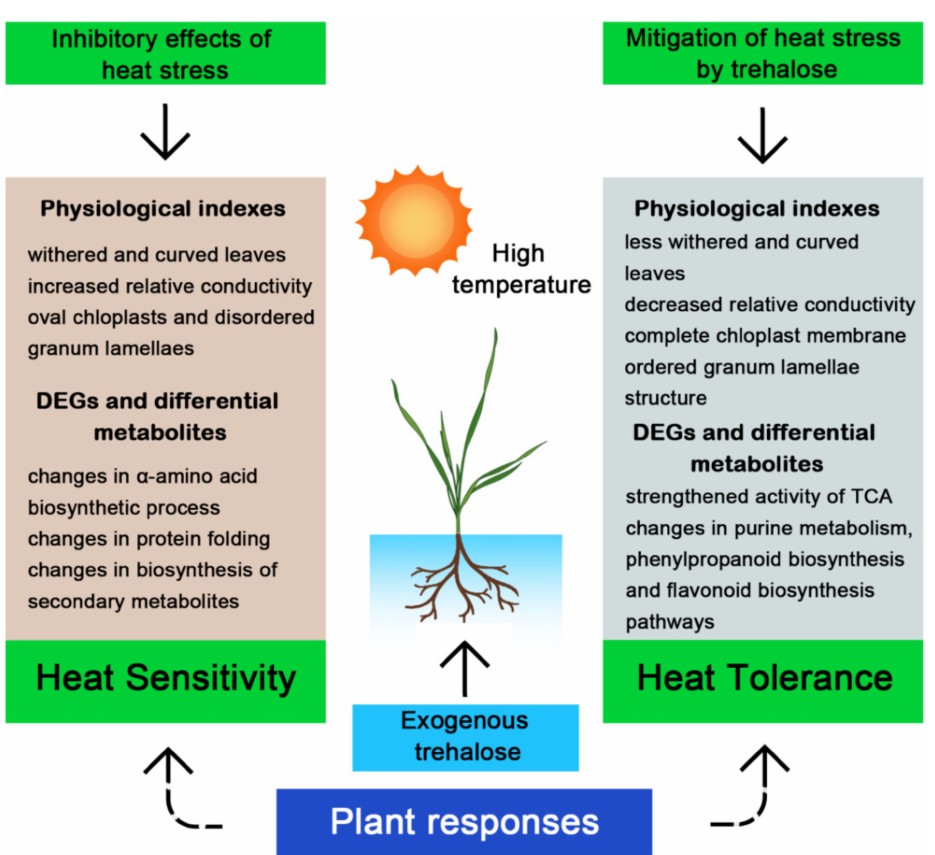
Figure 13. A proposed model of the mechanism of exogenous trehalose to alleviate the negative effect on wheat seedlings under high